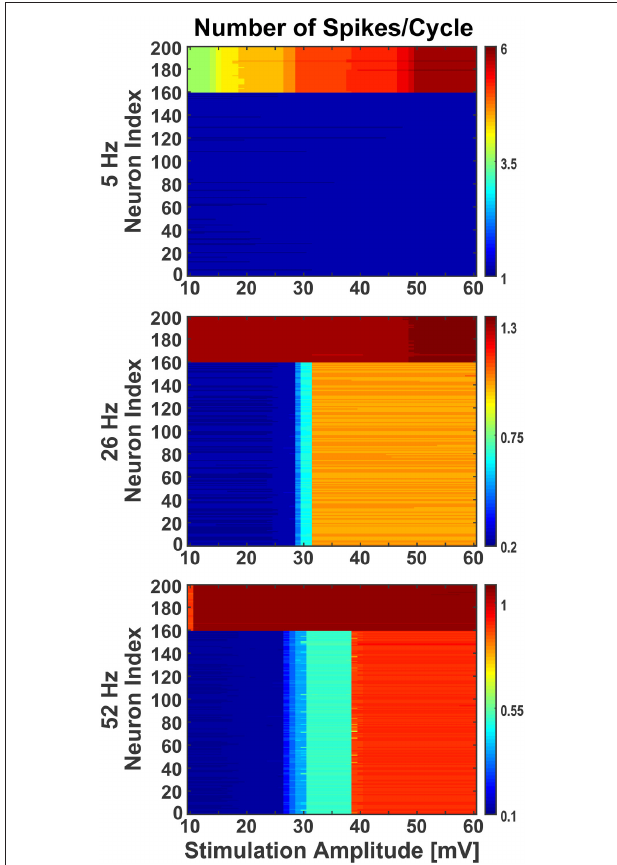
FIGURE 7 | Effect of stimulation amplitude on active network. The network was stimulated with varied amplitude of sinusoids ( 10 mV to 60 mV with step of 1 ) at three different frequencies (5Hz, 26Hz, and 52Hz), as in Figure 6 , when the network was activated by synaptic inputs from the background population. Even during the presence of background activity, stimulating the network with different amplitudes of sinusoids, the individual neurons’ firing behavior was comparable to the ones noticed at 38 mV. The Y-axis shows the neurons index where 1 to 160 are excitatory and 161 to 200 are inhibitory. The colorbar shows the number of spikes per